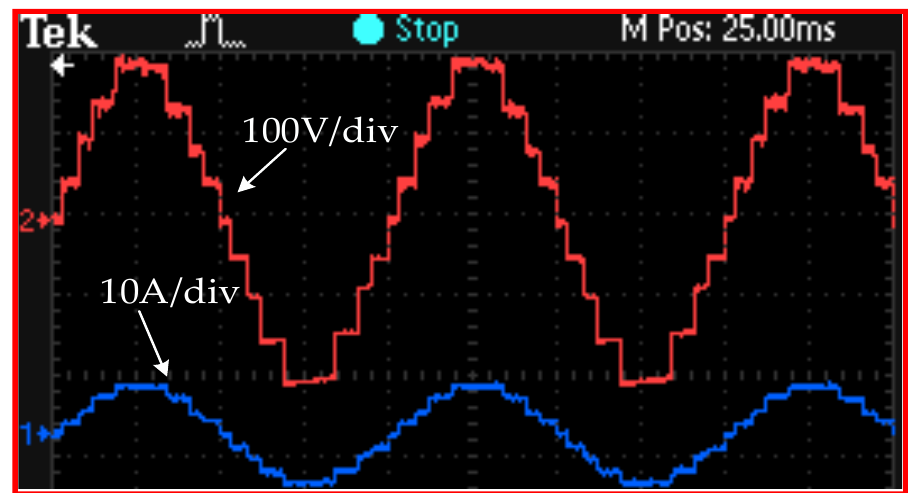
Figure 16. Voltage and current waveform at the RL load.